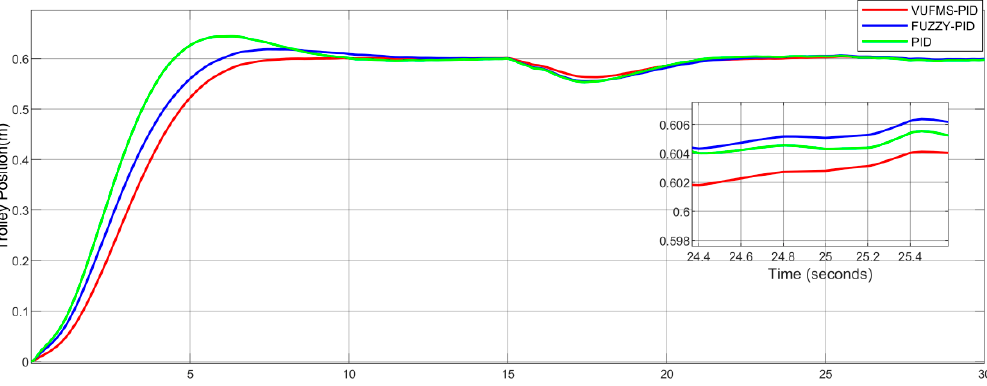
Figure 16. Payload’s swing angle using VUFMS-PID, FUZZY-PID and PID controller under work- ing condition 1 with a crosswind and white noise.